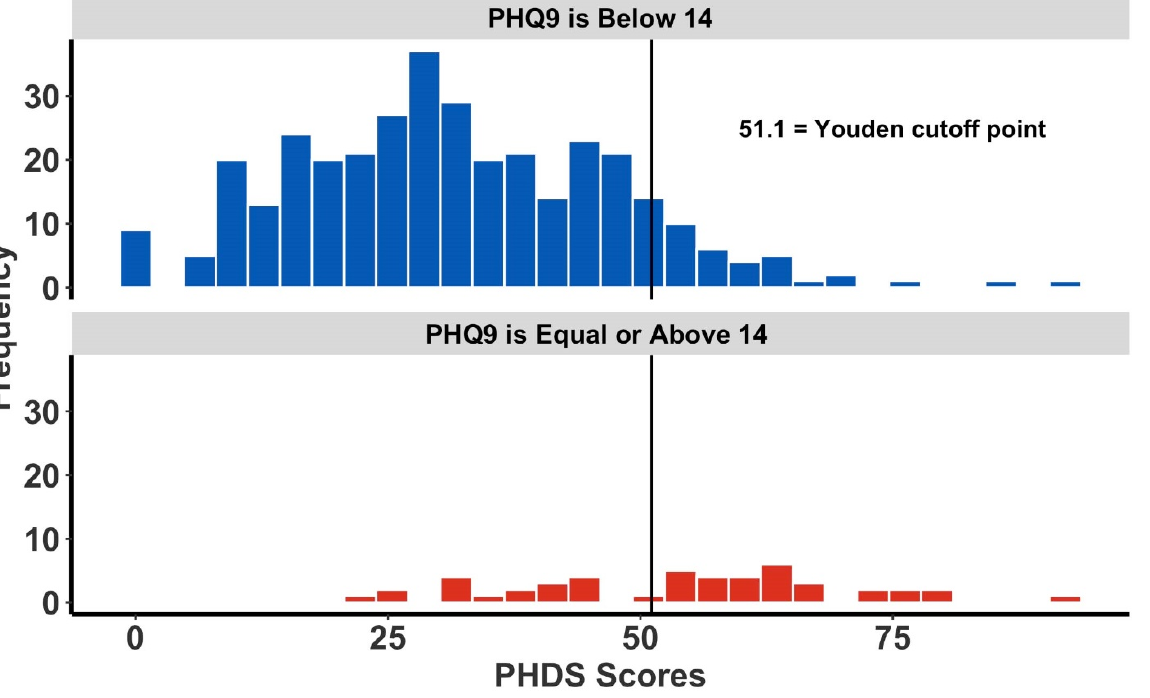
Figure 4. The frequency of Post-Hurricane Distress Scale (PHDS) scores and Patient Health Questionnaire 9 (PHQ-9) scores. The overlaid vertical line represents the PHQ-9-specific Youden cutoff point. The upper figure (in blue) is all respondents scoring below 14 on the PHQ-9, while the figure below (in red) represents individuals deemed high-risk for depression, having a PHQ-9 score of 14 or more.